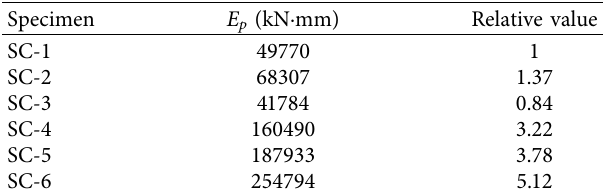
p ) of all specimens.